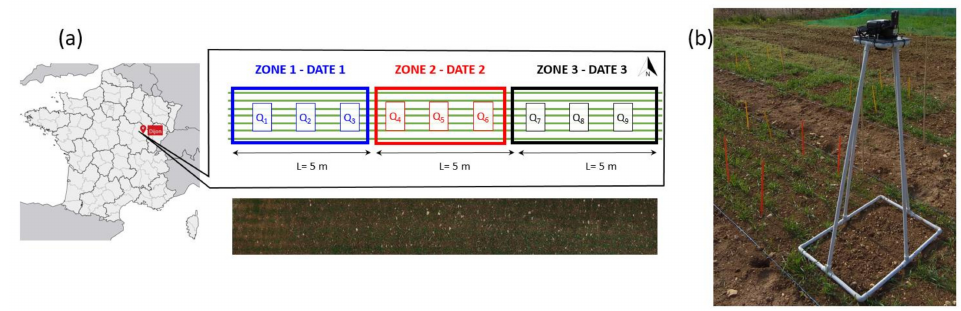
Figure 1. ( a ) Winter wheat field in Dijon, Burgundy, France; ( b ) Movable sensing platform equipped with a digital RGB camera and an automated triggering